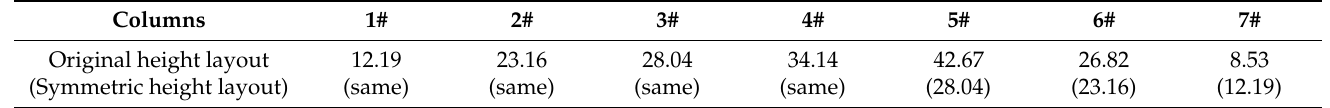
Table 3. Original and symmetric column height layouts (unit: m).